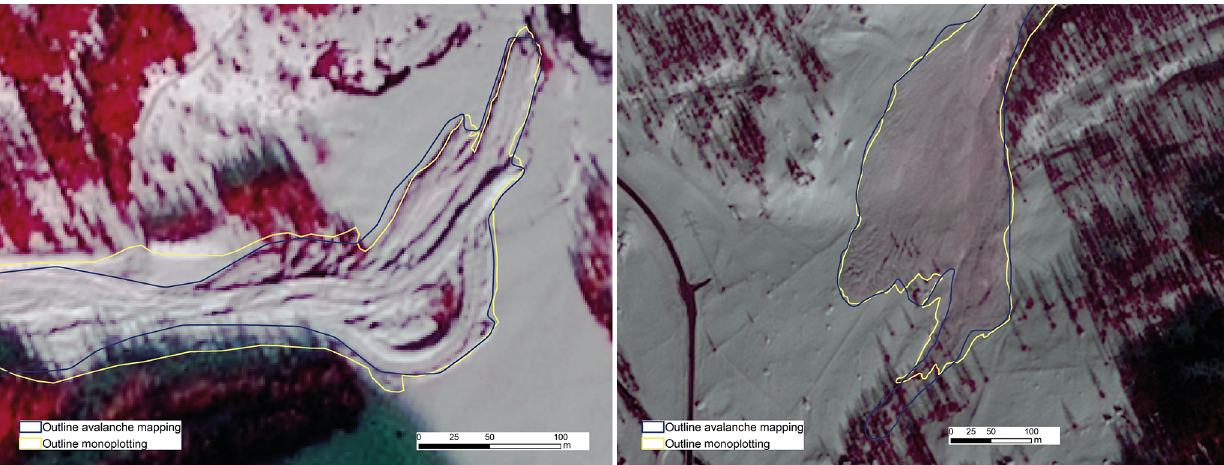
Figure 7. Comparison of mapped outlines (blue) with those from the monoplotting tool (yellow) for two different avalanches. The left avalanche is located in Trient, VS, and the one to the right is located in Simplon, VS. Especially in the shade, under trees and with thin deposits, there are considerable differences. In both images the background is SPOT6 imagery from 24 January (SPOT6 data © Airbus DS